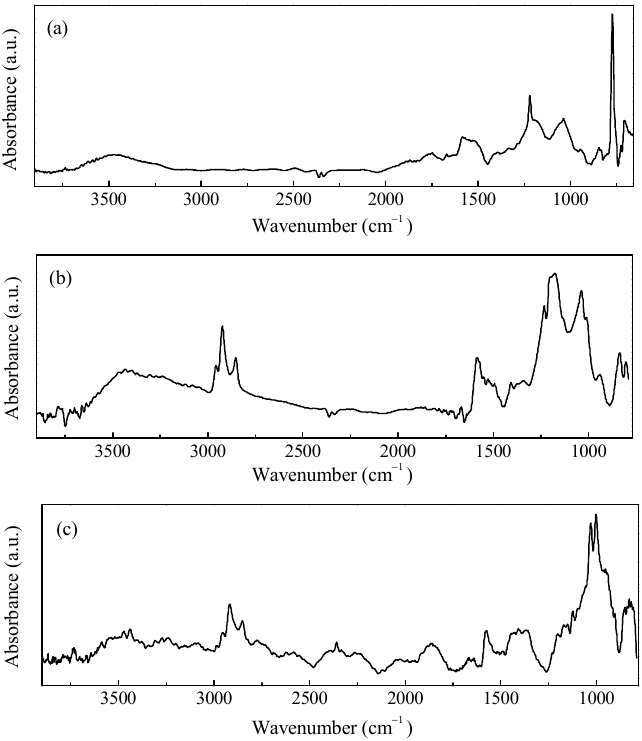
Figure 3. IR spectra of the PPy powder ( a ), PPY-DBSA ( b ), and PPy-GNP:DBSA ( c ). According to Figure 1a, PPy-GNP:DBSA films, when deposited on transparency sheets from the ink developed as previously described, also appear to be smooth, compact, and with good adherence to the substrates. On a smaller scale, the morphology of a typical PPy-GNP:DBSA film imaged in Figure 4c shows that the presence of graphene in the three- component mixture has a peculiar effect on the sample, which acquires a certain degree of PPy:DBSA film and on a PPy-GNP:DBSA film. Compared to Figure 4a, the morphology self-organization. We have previously observed a similar peculiarity when examining how of a typical film deposited from an ink containing PPy and DBSA at a ratio 1:5, as shown films deposited from mixtures containing GNP and DBSA at ratios below 1:2 and above 1:10 [21] show a tendency to organize themselves in a fairly ordered way over regions that are over a hundred micrometers in size. The PPy-GNP:DBSA film shown in the micrography of Figure 4c seems to consist of micron-sized aggregations of fairly oriented elements. These latter ones, according to the detailed view of the same sample reported in Figure 5b, have a peculiar shape that is composed of fibers that are tens nanometers wide and hundreds of nanometers